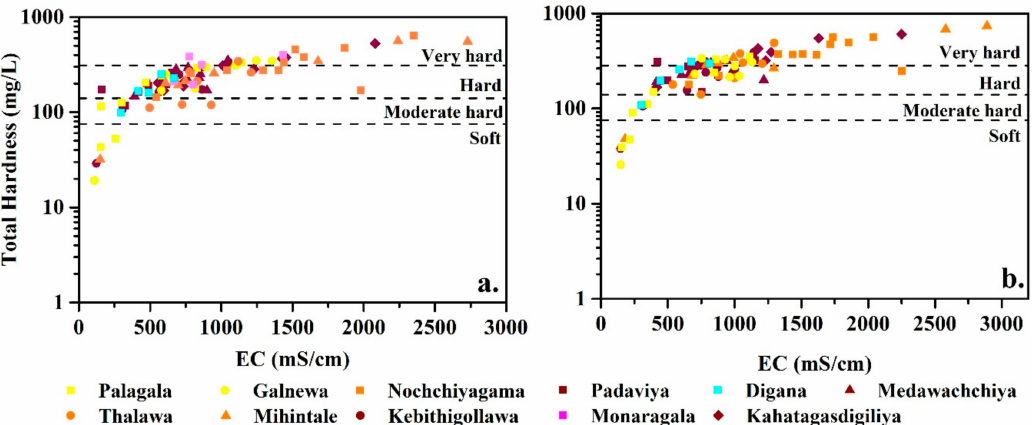
Figure 4. Relationship of hardness and electrical conductivity (EC) of groundwater from study areas in the ( a ) wet season and ( b ) dry